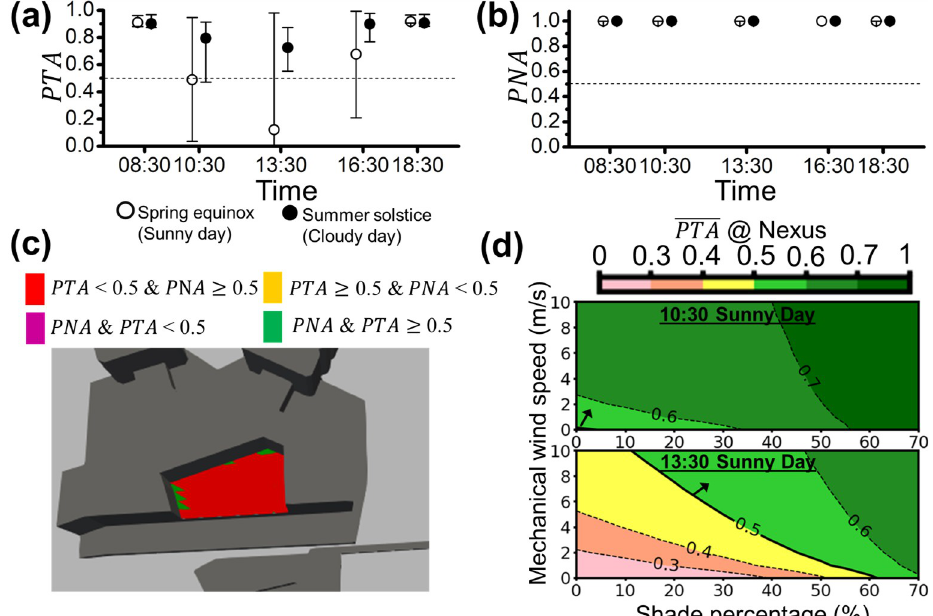
Fig 11. The area-averaged (a) PTA and (b) PNA of Nexus (site (iii)) for both sunny (open circles) and cloudy (filled circles) days are represented with open and filled circles (i.e., PTA and PNA ), respectively. The error bars extended from the area-averaged PTA or PNA (circles) represent the local maximum and local minimum PTA or PNA on Nexus. The environmental acceptability threshold of 0.5 is denoted by the dotted line (i.e., PTA = 0.5 or PNA = 0.5). (c) The spatial plot of PTA and PNA above or below the threshold of 0.5 for Nexus at 13:30 on the sunny day (worst case) is illustrated. (d) The contour plot shows the potential improvement of PTA with the increase in shade and/or wind speed at 10:30 and 13:30 on the sunny day for Nexus. Fig 11(A) and 11(B) show the area-averaged PTA and PNA of the sunny day and the cloudy day at the Nexus. In Fig 11(A), PTA s are higher than that shown in Figs 9(A) and 10(A), espe- cially on the cloudy day. However, the minimum PTA is still close to 0 on the sunny day, e.g., at 13:30 (worst case). From Fig 11(B), PNA is always close to 1 with almost zero variation that 100% of people satisfy the acoustic environment all the time during peak hours. The spatial feature of PTA and PNA at 13:30 on the sunny day as shown in Fig 11(C) can be seen that the most of area is with PTA < 0.5 marked in red, few scattered areas with PTA � 0.5 are marked in green, and almost no area is with PNA < 0.5. Fig 11(D) shows the improvement of PTA via two strategies on the sunny day. At 10:30 of the sunny day (the upper panel of Fig 11(D)), merely using increasing 0.2 m/s in wind speed or blocking 4.2% of solar irradiance can reach PTA = 0.5. In the lower panel of Fig 11(D), the baseline of PTA can be achievable by blocking 62% of solar irradiance at 13:30 of the sunny day but still be unachievable by solely increasing the wind speed. Fig 12(A) and 12(B) show the area-averaged PTA and PNA with the corresponding varia- tion of the sunny day and the cloudy day at the market village. Similar to the results (see Fig 9 (A)), PTA s are less than 0.5 and the corresponding minimum PTA s are close to 0 at 10:30 and 13:30 of the sunny and cloudy day as shown in Fig 12(A). It can be observed that the maximum PTA s at 10:30 and 13:30 of the sunny and cloudy day are much less than those elsewhere. On the other, in Fig 12(B), PNA s are between 0.69 and 0.73, slightly less than that shown in the results from Figs 9(B), 10(B) and 11(B). The corresponding minimum PNAs are close to 0 all